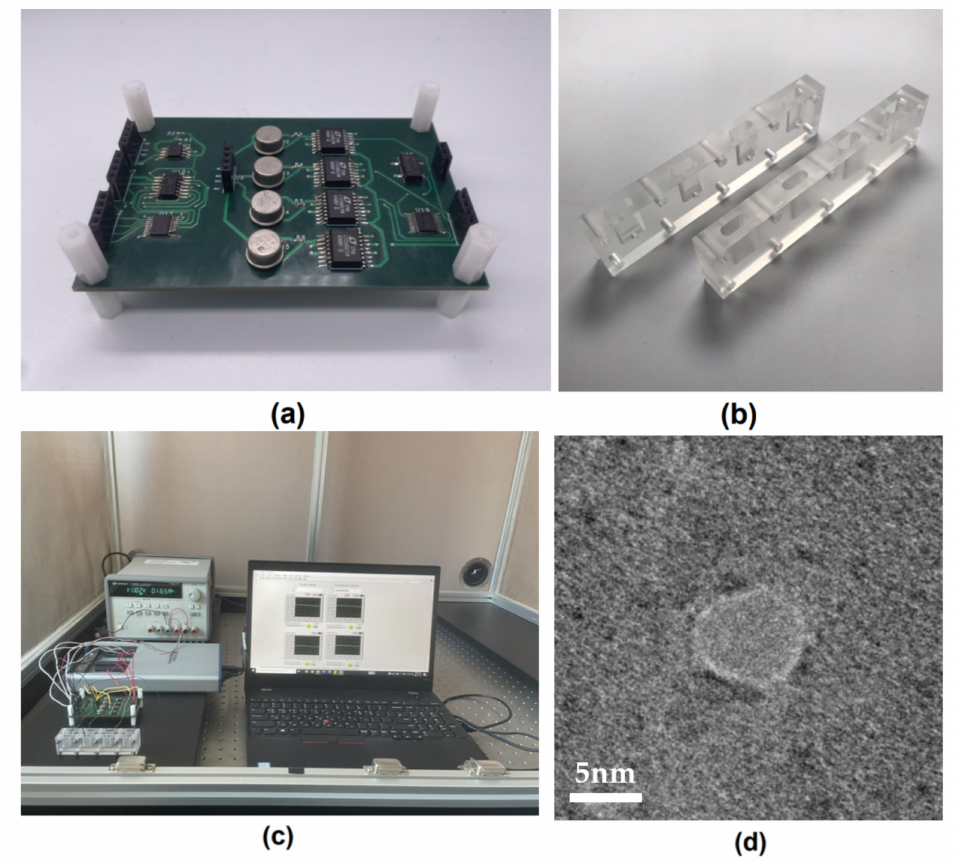
Figure 4. ( a ) Photograph of the proposed CDB system, with an area of 57 cm 2 ; ( b ) customized flow cells with four cis -chambers and one trans -chamber; ( c ) complete CDB experimental setup; ( d ) nanopore microphotographed via TEM (Transmission Electron Microscopy).